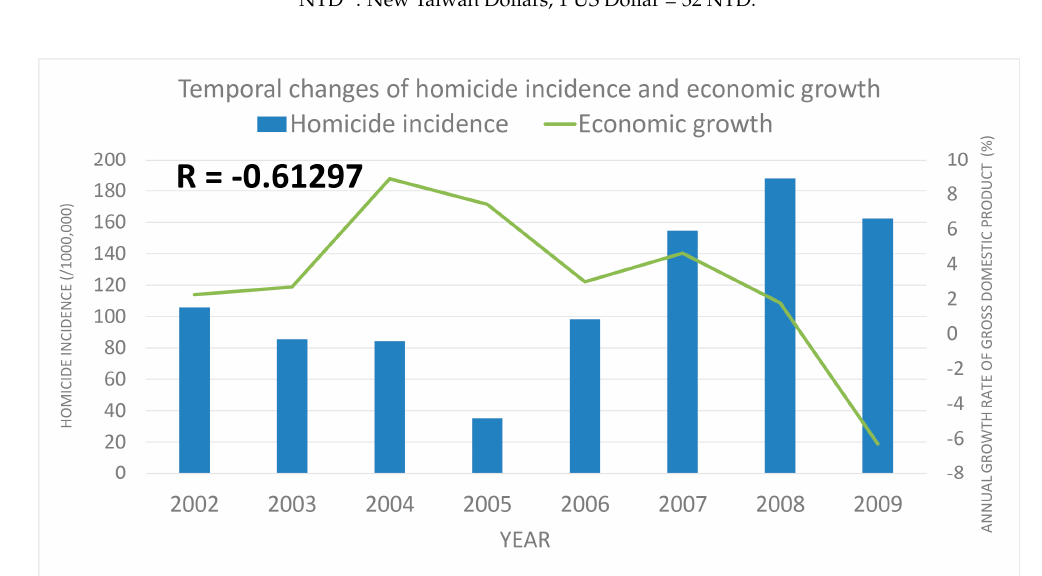
Figure 5. The temporal change of economic growth and homicide rate between 2002 and 2009.